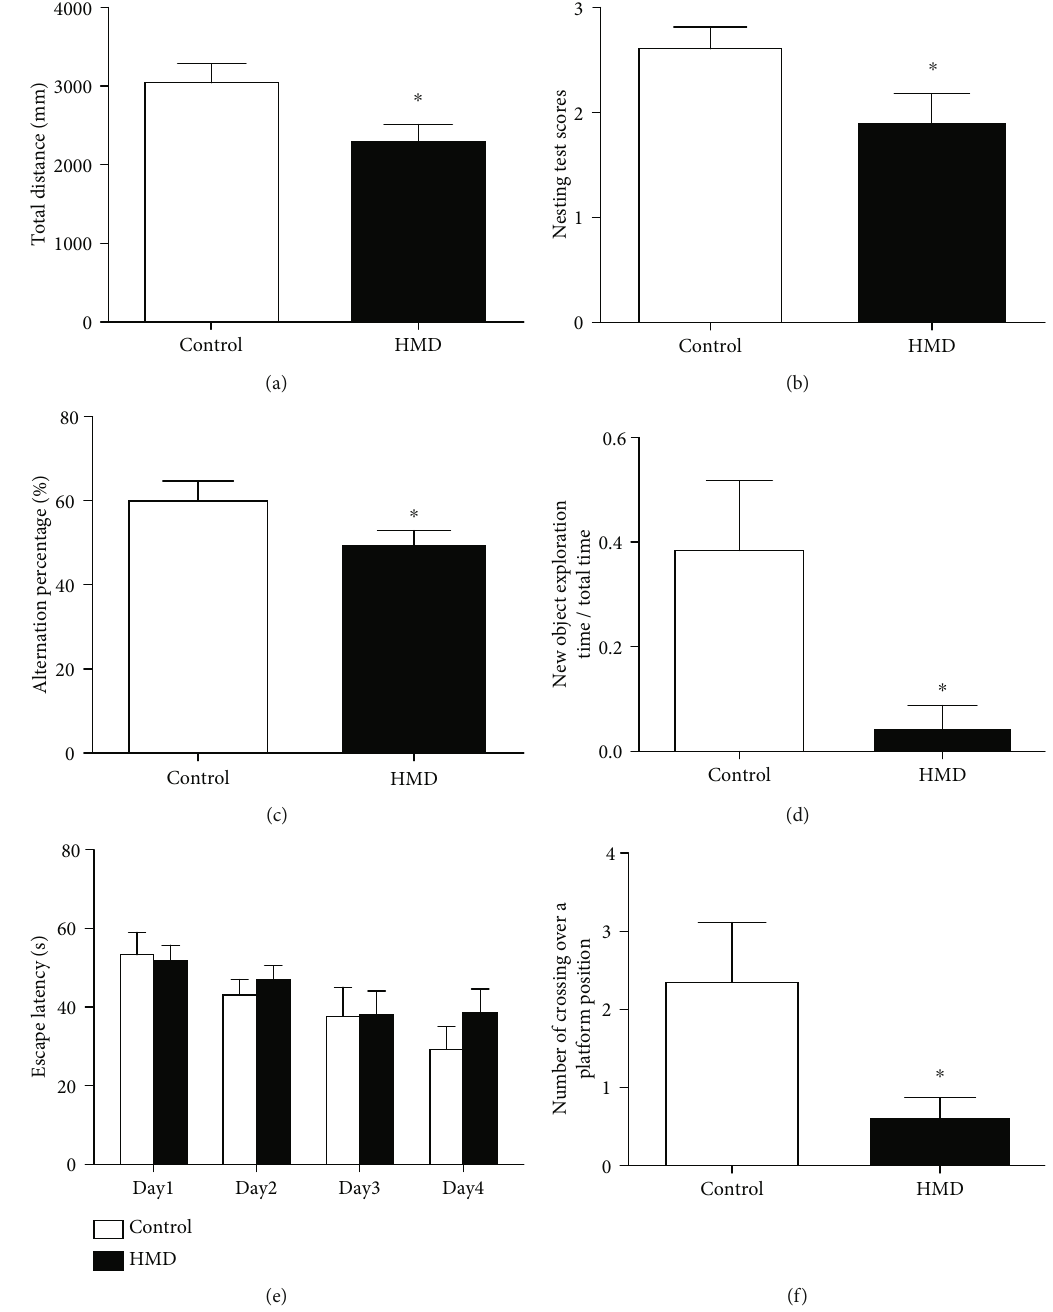
Figure 2: E ff ect of HMD on behavioral test of mice. (a) Total distance in the open- fi eld test of each group. (b) Nesting test scores after 24 h of each group. (c) Alternation percentage % of each group. (d) New object exploration time/total time of each group. (e) The escape latency of each group. (f) Number of crossing over a platform position for 60 s. Note: the values were expressed as mean ± SEM ( n = 8 ). ∗ p < 0 : 05 vs. control